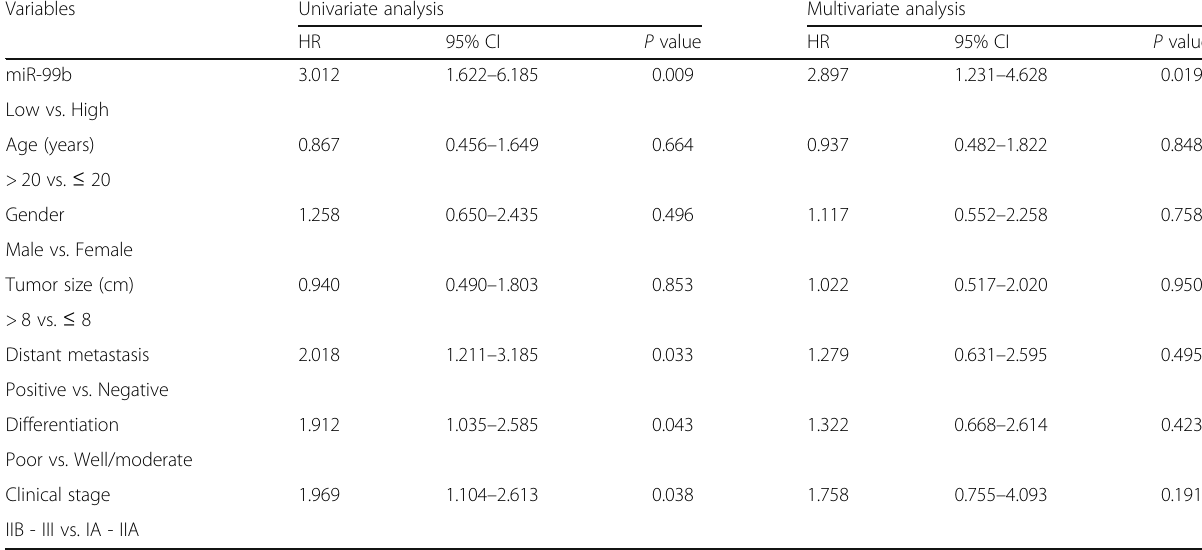
Table 2 Cox regression analysis in the patients with OS Variables Univariate analysis Multivariate